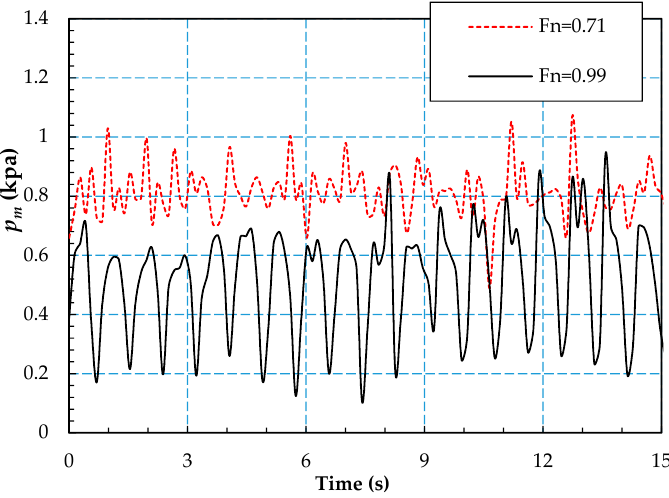
Figure 12. Midship pressure monitored in waves for different speeds.